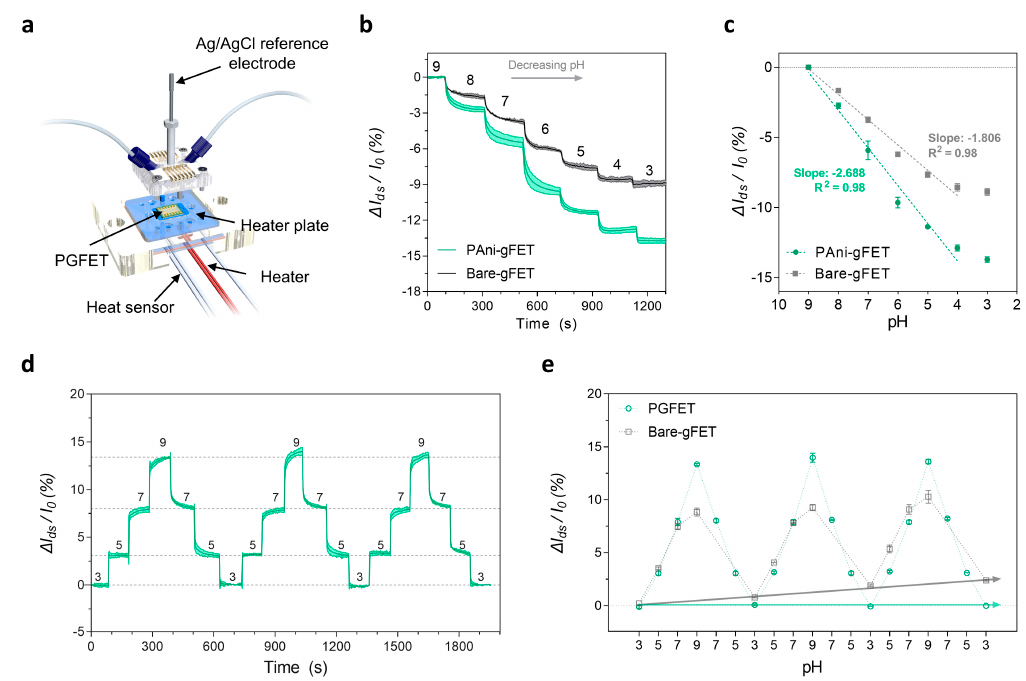
Figure 3. pH-sensing performance of the bare-gFET and PGFET. ( a ) Schematic illustration of the customized jig for real-time monitoring in a flow configuration. ( b ) The real-time monitoring depending on the pH variation from 9 to 3 in the bare-gFETs and PGFETs. ( c ) The linear plots of the bare-gFET and PGFET for the analysis of pH sensitivity. ( d ) The real-time output responses of PGFETs for three pH cycles. ( e ) The output responses of bare-gFETs and PGFETs as a function of cyclic pH variations for representing the pH-hysteresis of each device. The light band around the curves represents pointwise 95% confidence intervals derived from n = 3 independent measurements.